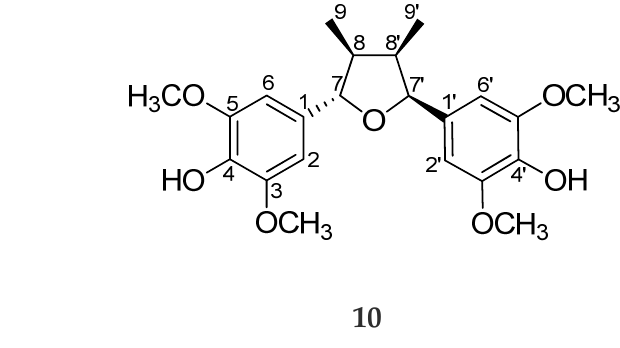
Figure 1. New isolated compounds ( 1 – 10 ) from E. gossypina var. coccinea.